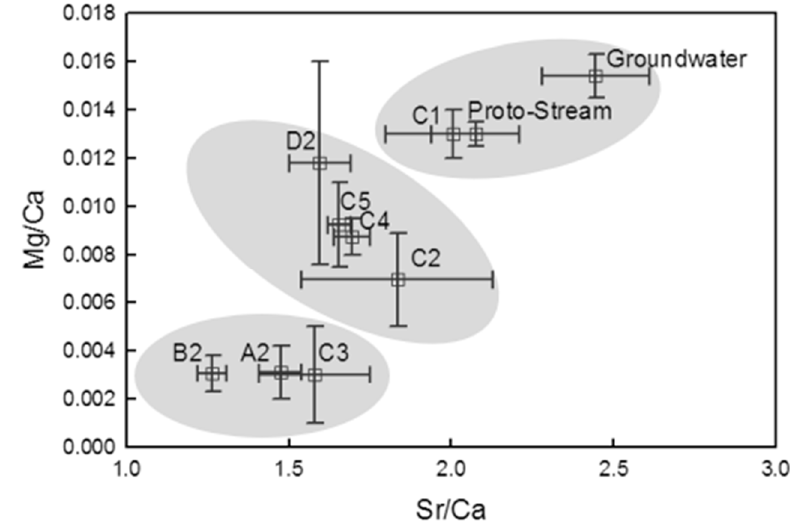
Figure 6. Wetland porewater and source water geochemical analyses. Mg and Ca measured in mg/L; Sr measured in µg/L. Error bars show mean ± SEM.